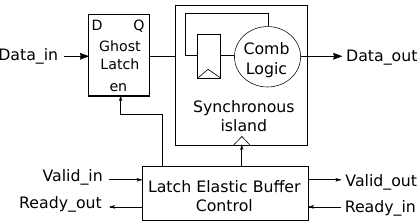
F IGURE 5.4: Elasticization of synchronous systems Figure 6. Principe of Elasticization of synchronous circuits.